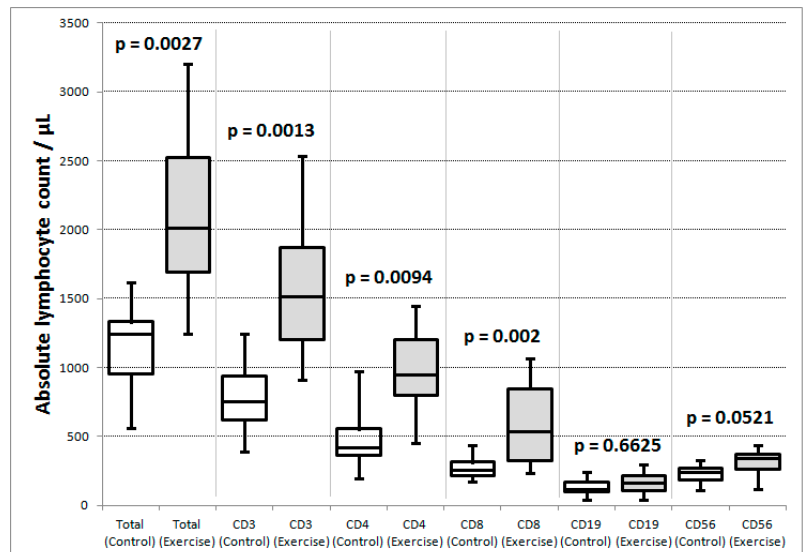
Figure 7. Comparison of absolute lymphocyte counts per μ L between exercise (white box plots) and control groups (shaded box plots). Maximum, minimum, quartiles and median are illustrated for each distribution. The p values are for Mann–Whitney tests.